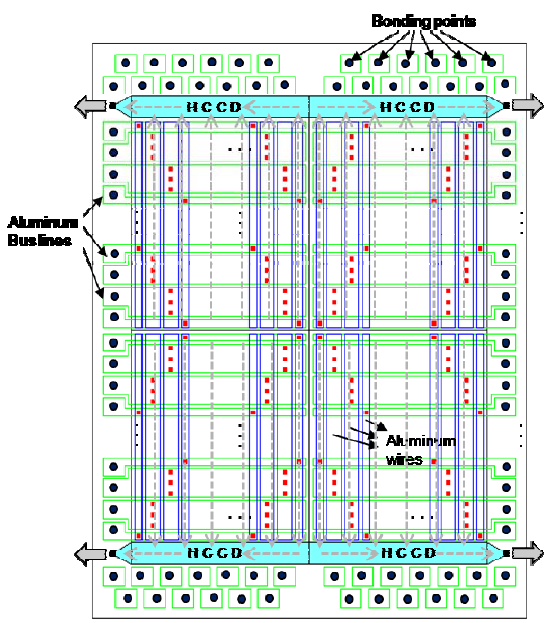
Figure 1. Architecture of the ISIS-100M chip.